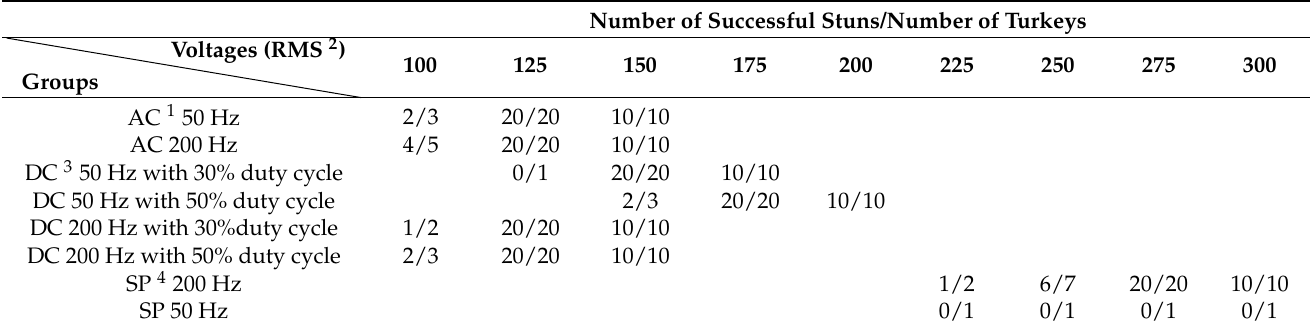
Table 3. Treatment groups showing the number of successful head-only stunned